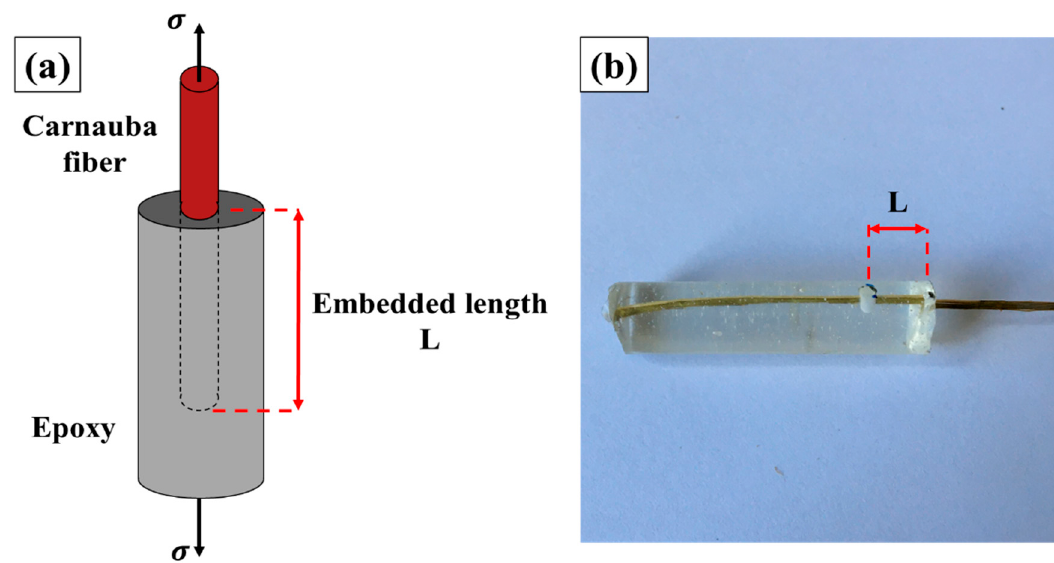
Figure 4. Scheme for pullout test ( a ) and ( b ) epoxy-carnauba specimen.